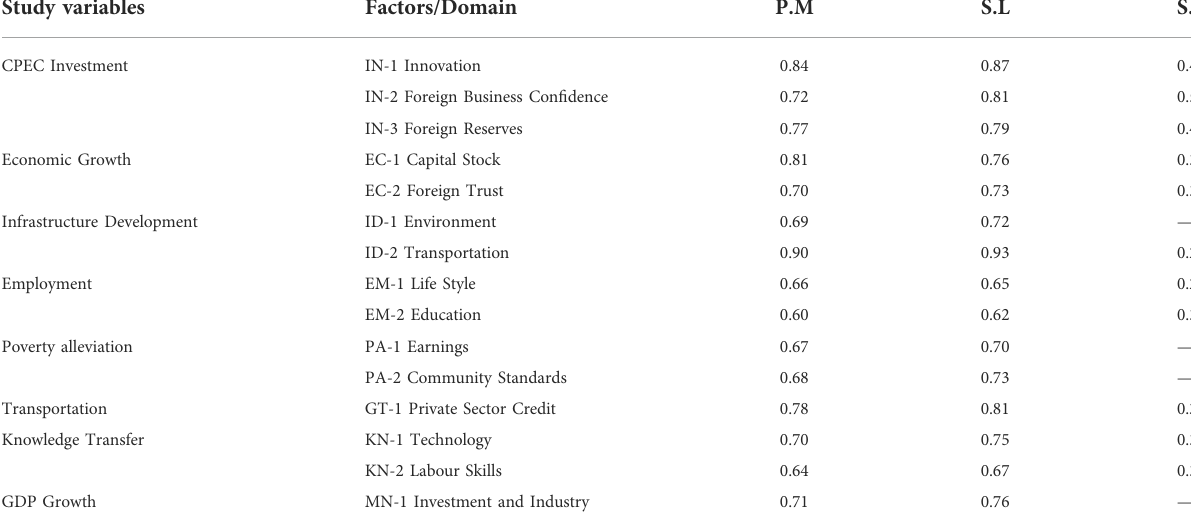
TABLE 6 Study variables. Study